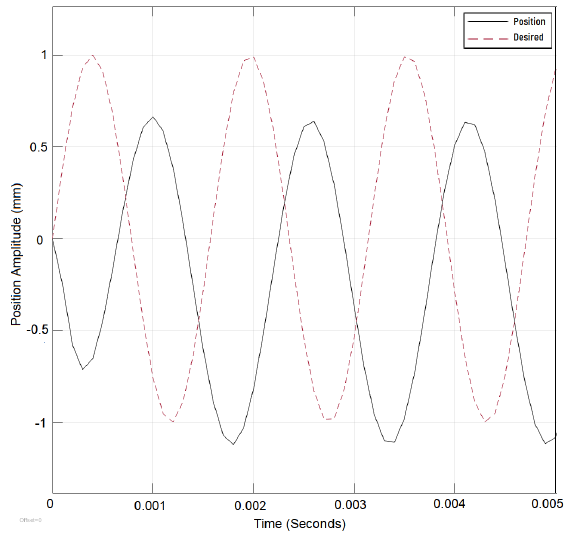
Figure 8. Lyapunov controlled position with reference to sinusoidal wave of 4000 rad/s frequency.